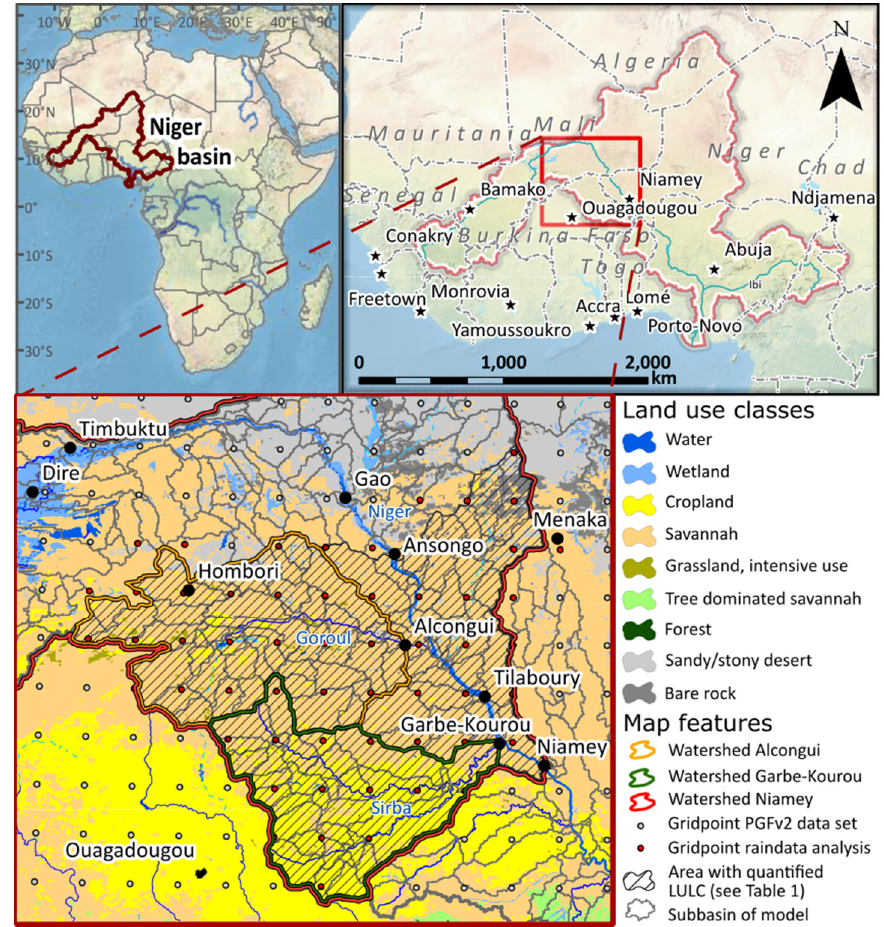
Figure 1. Map of the research area in West Africa including land use classes used in the model as base map in the year 2000. The orange, green, and red outlines mark the watershed of the gauging stations Alcongui (Goroul River), Garbe-Kourou (Sirba River) and the watershed of Niamey (Niger River). The grey dots show the grid of the PGFv2 climate reanalysis data set. The red dots show the grid of the climate data used for the analysis. The hatched area marks the region which is used for the quantification of land use and land cover